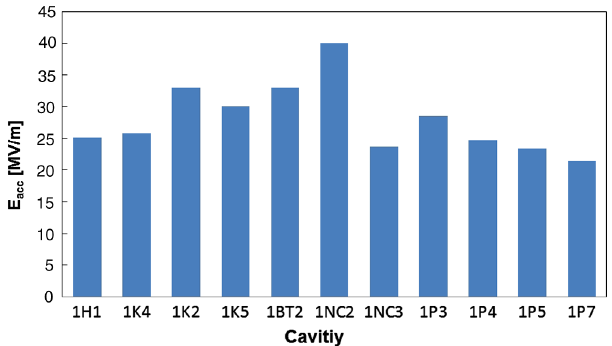
FIG. 28. Maximal accelerating gradients of BCP treated single- cell hydroformed cavities.